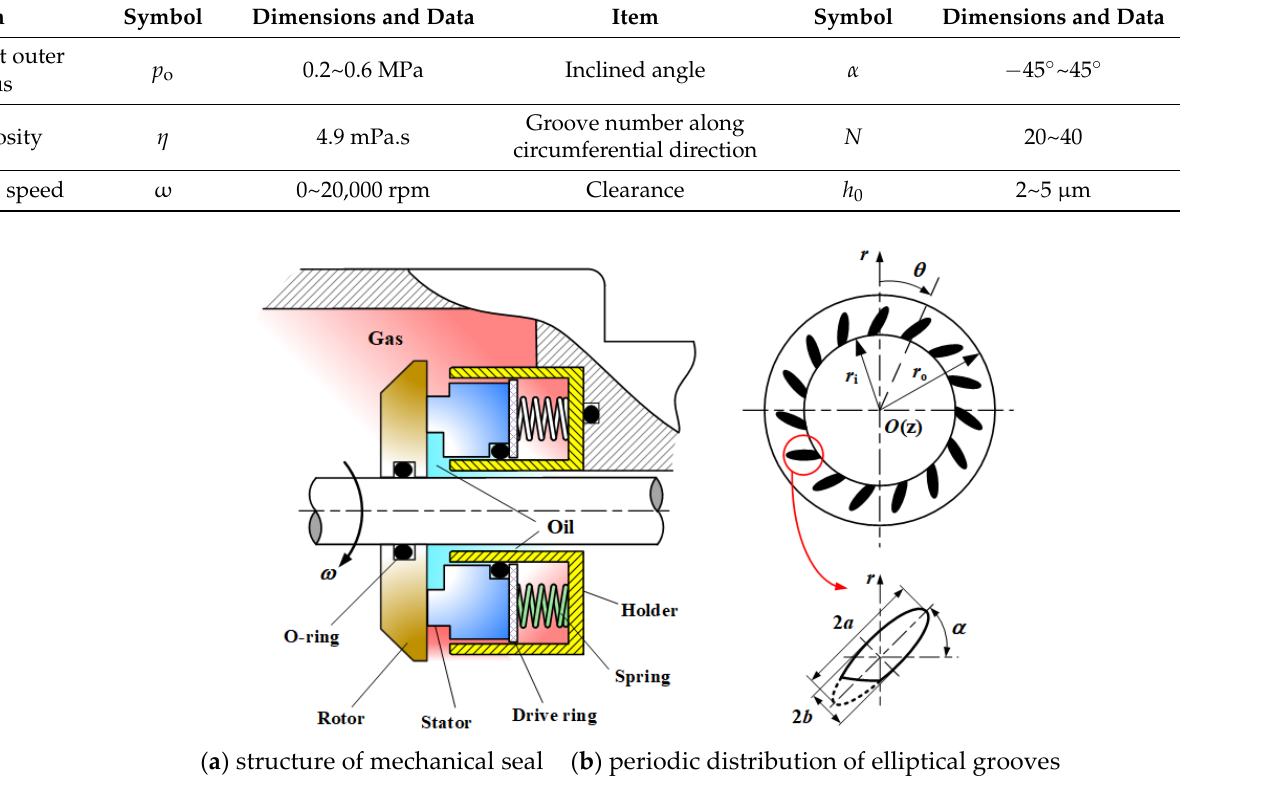
Table 1. Parameters of the mechanical face seal.